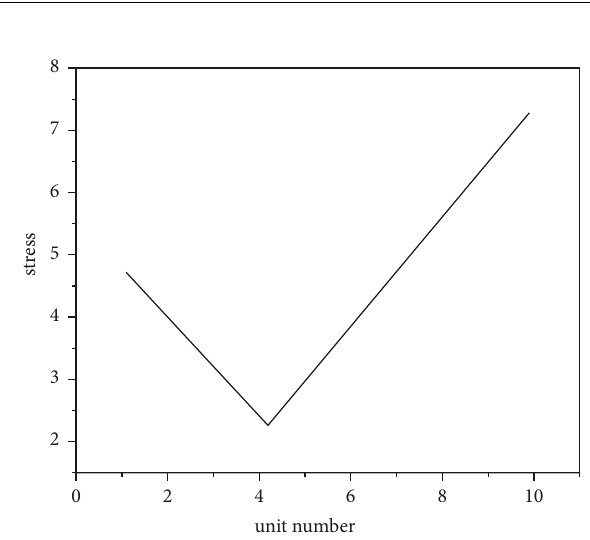
Figure 4: Variation of unit